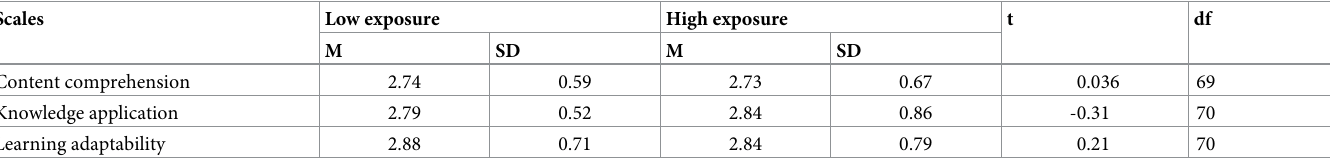
Table 7. Descriptive statistics and t -test results for learning challenges (low exposure vs. high exposure). Scales Low